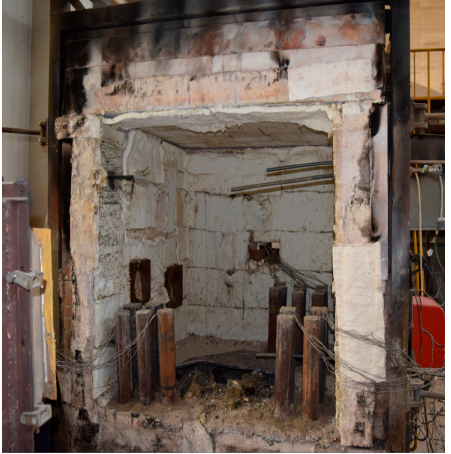
Figure 15. Vertical fire furnace.